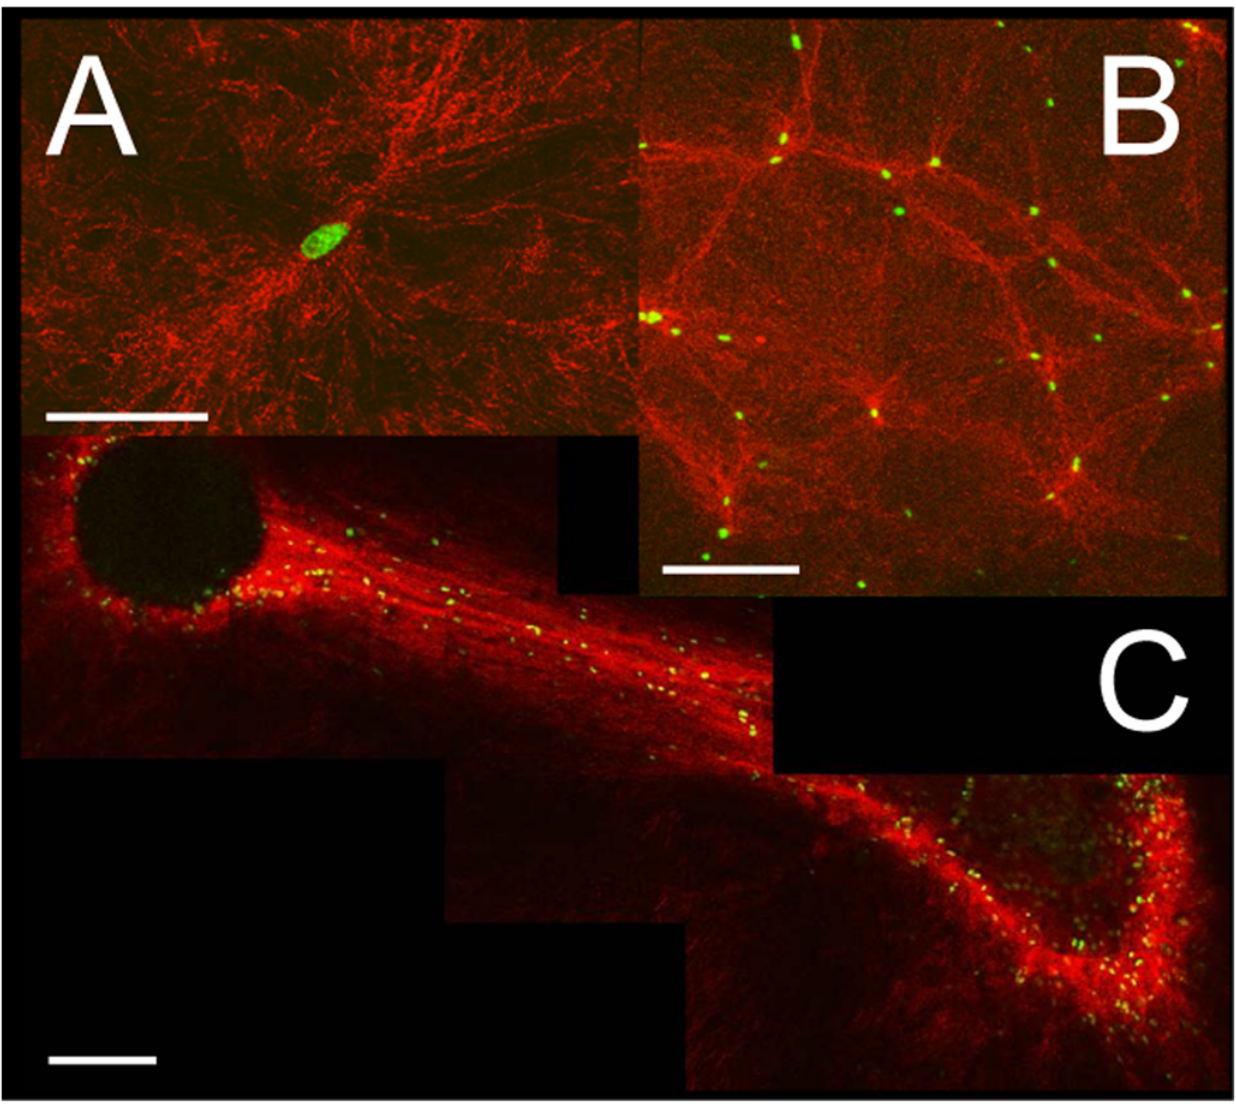
Figure 1. Collagen gel morphological changes induced by presence of cells. (A) Single U87 glioblastoma cell in a collagen network 10 hours after gel polymerization. bar=50 m m. (B) Several U87 cells on the surface of a collagen gel 10 hours after gel polymerization. bar=200 m m. (C) Two cell colonies embedded in a collagen matrix 48 hours after gel polymerization. bar=200 m m. Fibers (artificial red color) are imaged through confocal reflectance; cell nuclei (green) are labeled with a GFP-histone heterodimer.